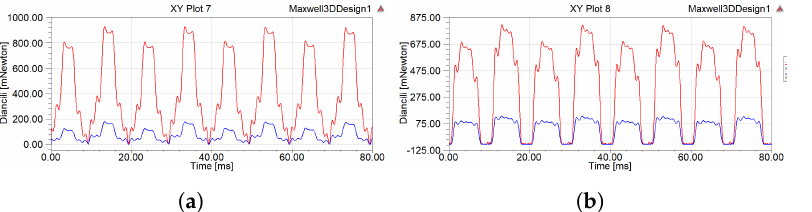
Figure 19. Dynamic response curves of electromagnetic force on each winding under working condition 1. ( a ) The left column. ( b ) The right column.